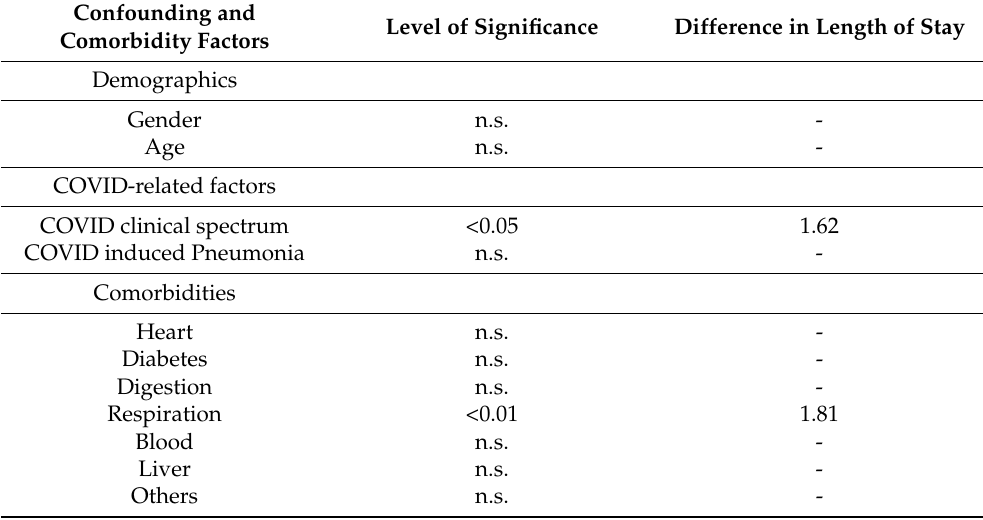
Table 7. Patients’ confounding factors and their relation to length of